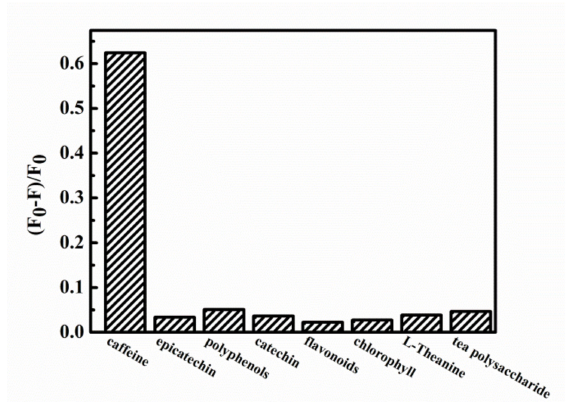
Figure 3. Fluorescence response of the 3,5-diaminobenzoic acid on ca ff eine and other major components in tea.